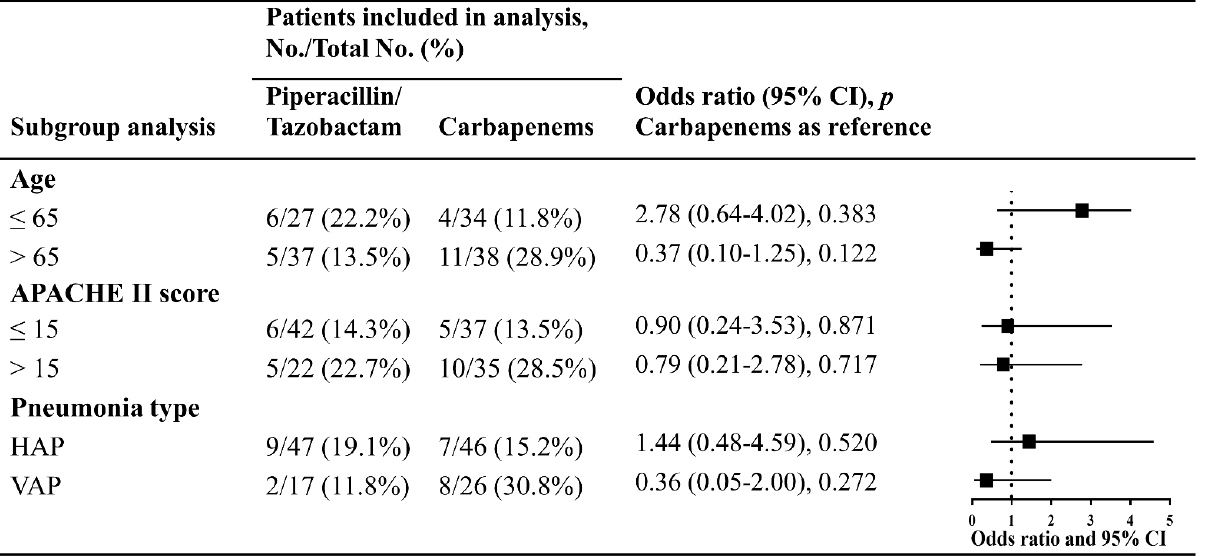
Figure 4. Subgroup analysis of the primary outcome in patients with nosocomial pneumonia caused by ESBL-producing K. pneumonia . The odds ratio and 95% confidence intervals for the 28-day mortality in each subgroup were estimated using carbapenems as the reference and adjusted for age and APACHE II score. HAP, hospital-acquired pneumonia, not including patients with VAP; VAP, ventilator-associated pneumonia; APACHE II score, Acute Physiology and Chronic Health Evaluation II score.